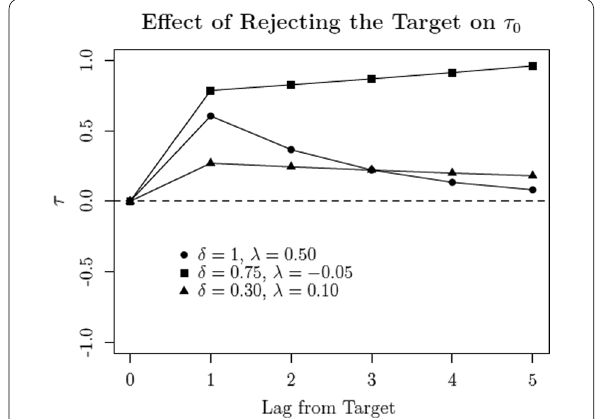
Fig. 4 Effect of previously encountering and rejecting the target on τ 0 , as a function of parameters δ and (cid:31) . Lag = 0 denotes the value of τ when the target is